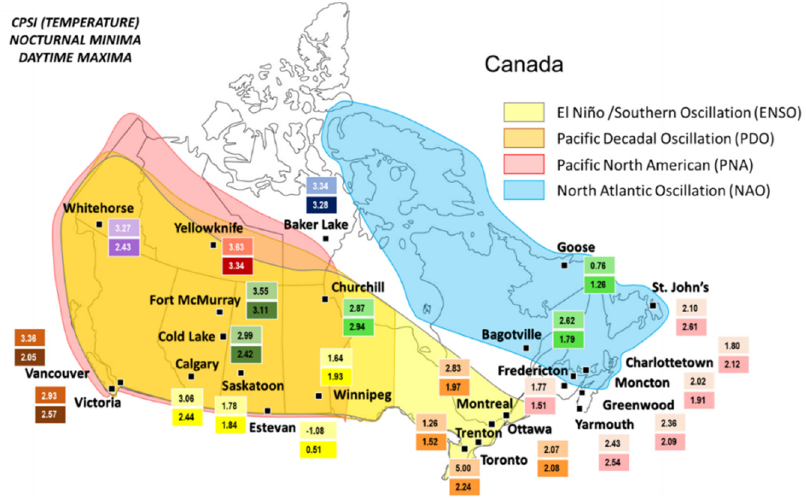
Figure 12. The CPSI of temperature minima ( upper row values ) and maxima ( lower row values ) of study locations within the range of influence of large-scale teleconnections affecting the climate of Canada. The CPSI indices are expressed in percentages and presented on color-coded fields corresponding to the colors of shading selected for identifying Canadian climate regions from Figure 3. The map of Canada with regions impacted by large climatic patterns (Adapted from Large-Scale Climate Oscillations Influencing Canada, 1900–2008 by Bonsal and Shabbar, 2011. Copyright 2011 by Her Majesty the Queen in Right of Canada).